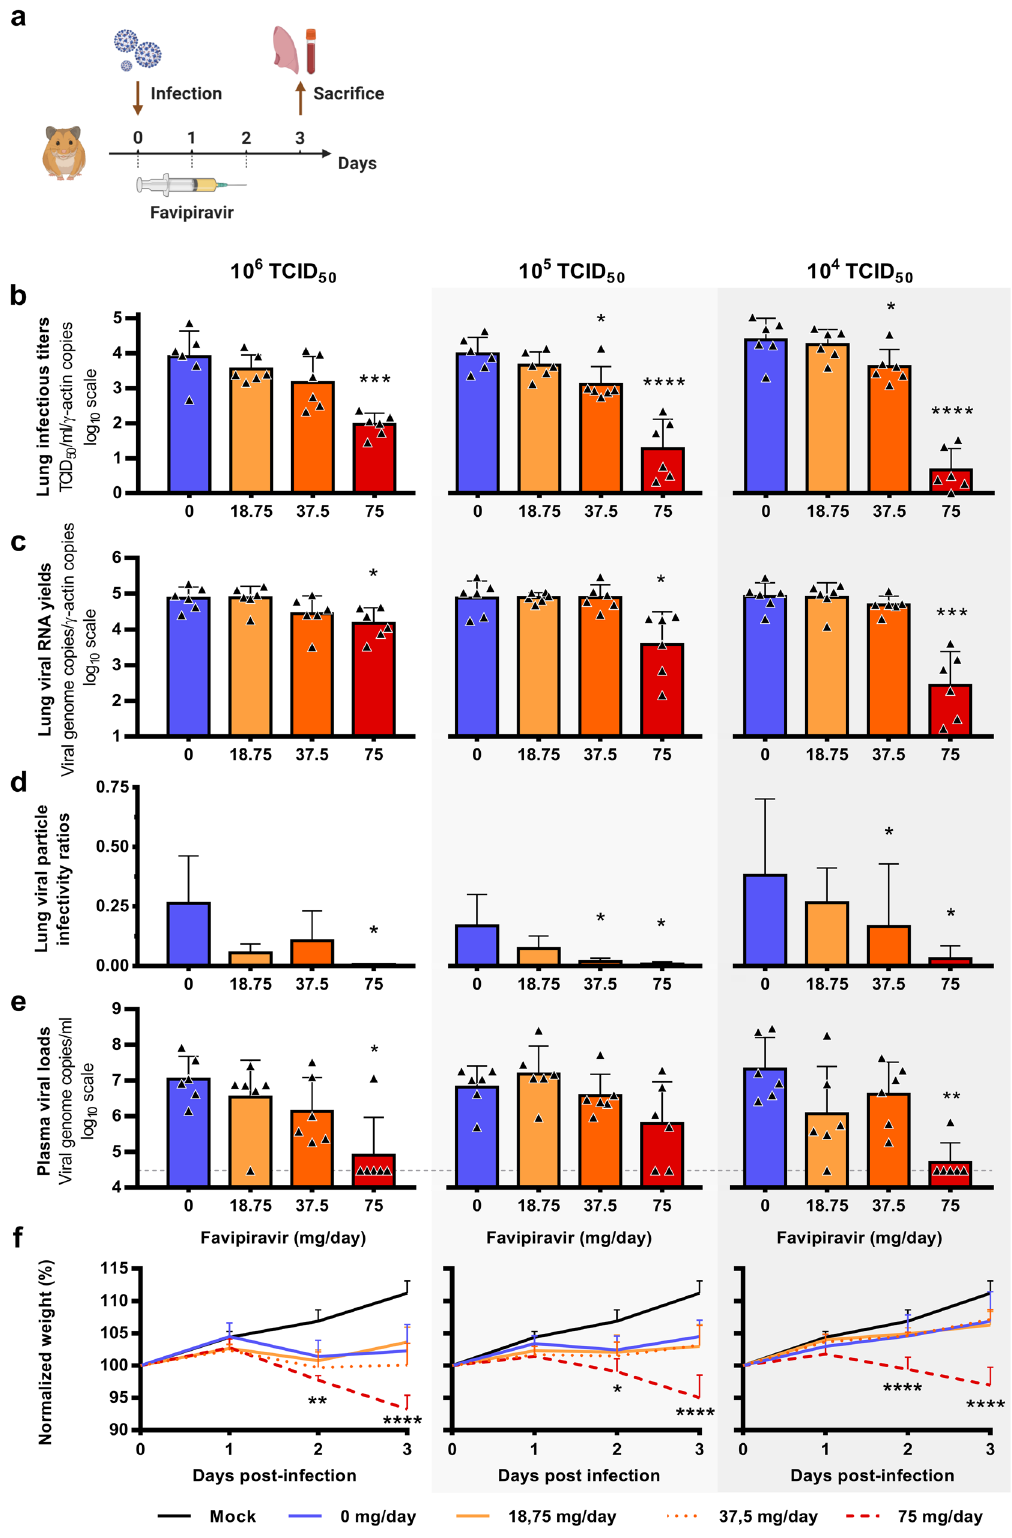
concentration after multiple dose in animals intranasally infected with 10 5 TCID 50 of virus. Groups of nine animals received the three doses evaluated for 3 days (Fig. 1): 18.75 mg/day, 37.5 mg/ day or 75 mg/day TID and were sacri fi ced at 12-h after the last treatment dose. Favipiravir trough concentrations were quanti fi ed in plasma ( n = 9) and lung tissue ( n =